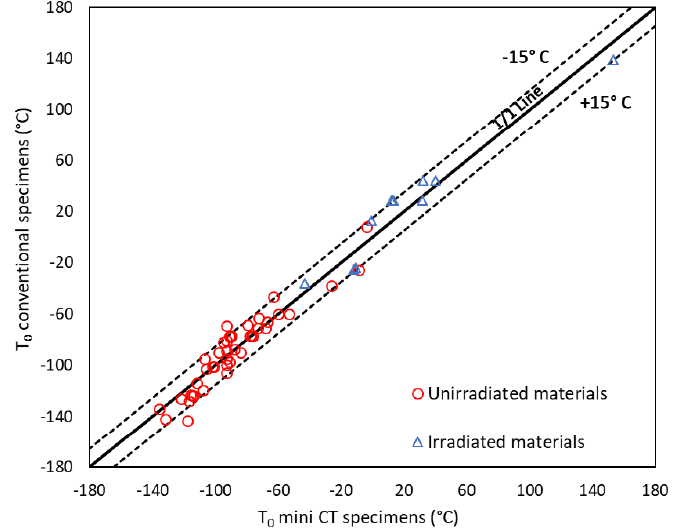
Figure 5. Comparison between T 0 values of unirradiated materials determined from conventional specimens and T 0 values obtained using mini-CT specimen. Results from: [7 – 9,11 – 15,18,20,22,23,25 – 27,29 – 31,33 – 35,37,38,40,42,44 – 46].